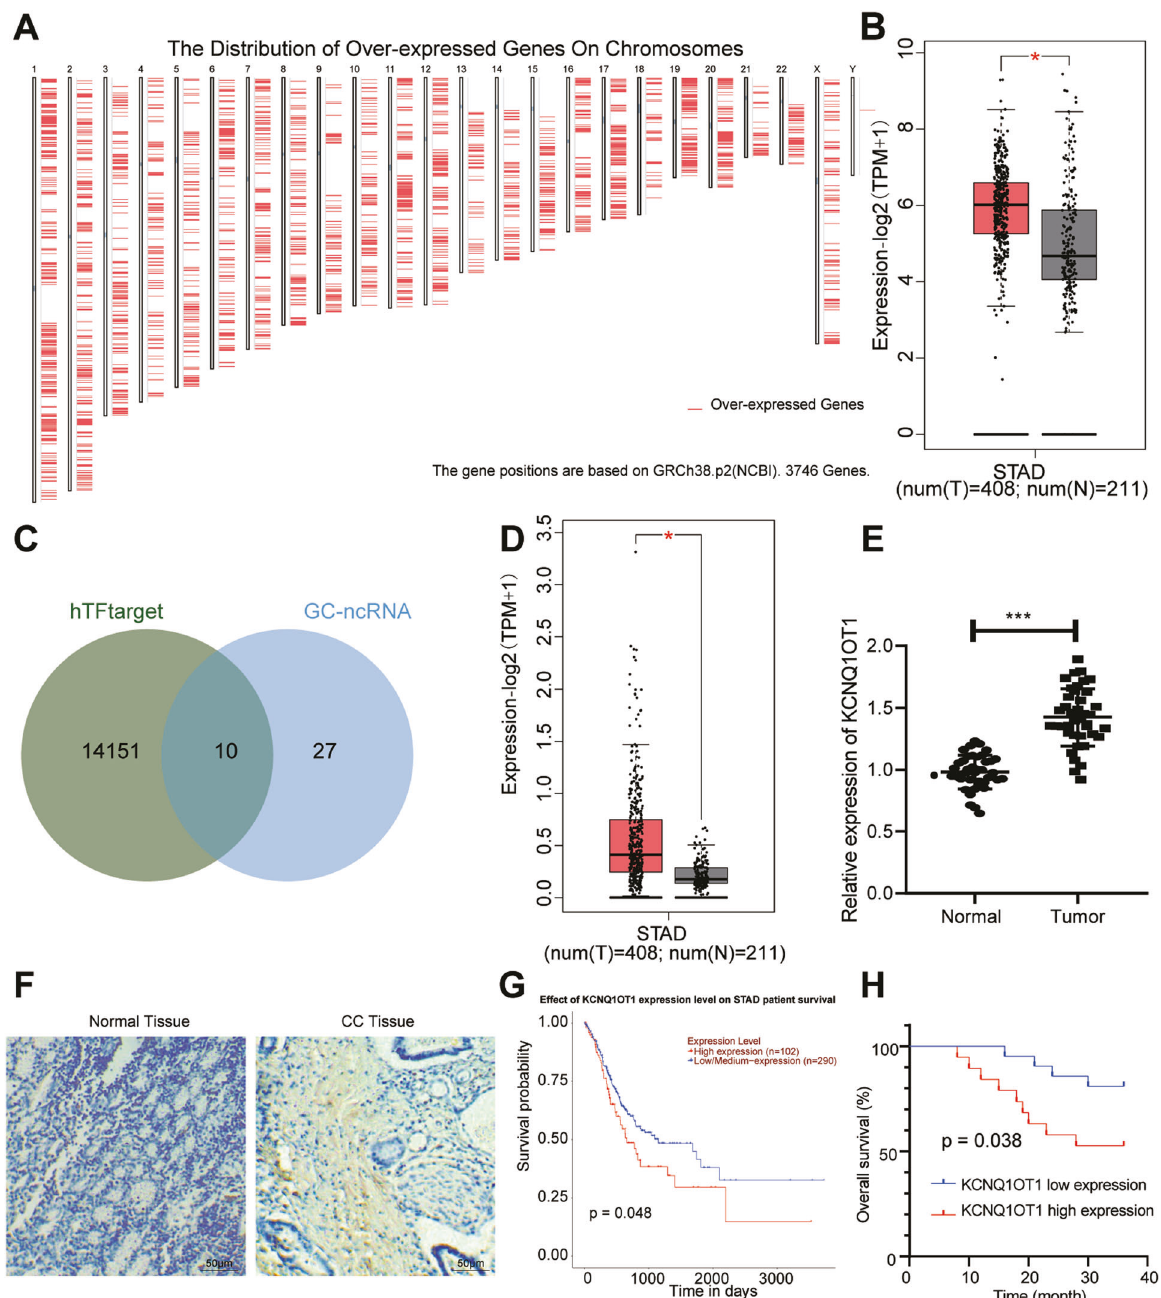
Fig. 1 c-Myc and KCNQ1OT1 expression is high in GC tissues. A GEPIA (http://gepia2.cancer-pku.cn/) was used to analyze the chromosomal location of upregulated 3746 genes in GC. B GEPIA website was used to analyze the expression of c-Myc in adjacent normal tissues and GC tissues (Red represents GC, N = 408; Gray represents adjacent normal tissues, N = 211). C Venn diagram of GC-related ncRNAs in GeneCards database (https://www.genecards.org/) and hTFtargets (http://bioinfo.life.hust.edu.cn/hTFtarget#!/)-predicted candidate targets of c-Myc formed by jvenn (http://jvenn.toulouse.inra.fr/app/example.html). D GEPIA website was used to assess the expression of KCNQ1OT1 in adjacent normal tissues and GC tissues (Red represented GC, N = 408; Gray represented adjacent normal tissues, N = 211). E, Expression of KCNQ1OT1 in adjacent normal tissues and GC tissues determined by RT-qPCR ( N = 40). F ISH was conducted to detect the expression of KCNQ1OT1 in adjacent normal tissues and GC tissues (scale bar: 25 μ m). G The relationship between the expression of KCNQ1OT1 and